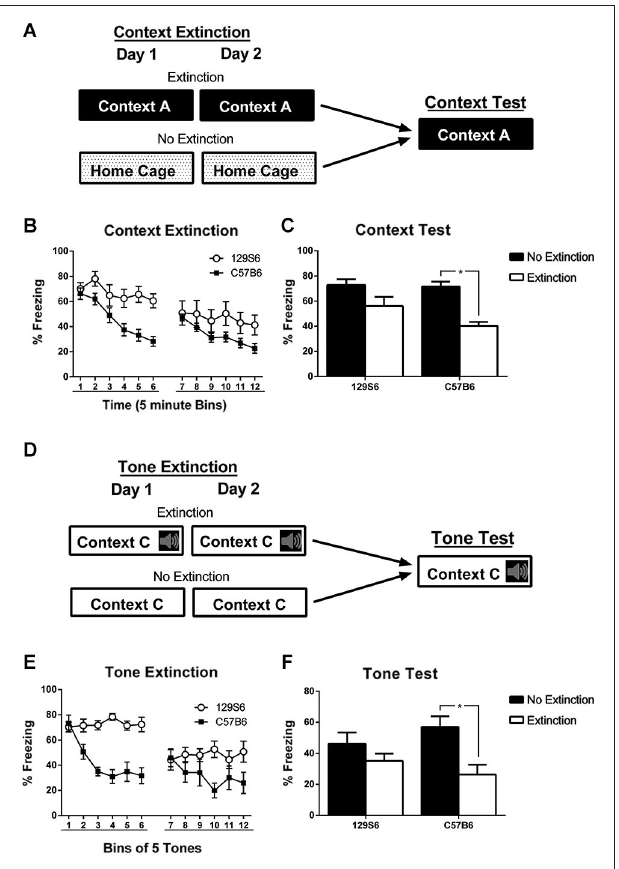
FIGURE 2 | Inbred mouse strain 129S6 shows deficits in context and tone extinction . (A) Schematic representation of context extinction. Mice were trained to a context or tone using 3 tone-shock or unsignaled footshock presentations per day for 3 days. Subsequently, mice were split into extinction and no extinction groups. Mice that were trained to a context were extinguished to the training context using 60 min of context exposure split across 2 days. Mice that were trained to fear a tone were extinguished with 60 tone-alone presentations split across 2 days. Extinction data is binned in groups of 5 min or 5 tones with bins 1–6 representing day 1 of extinction and bins 7–12 representing day 2. Twenty four hours later all mice (both the extinction and no extinction groups) were exposed to the training context or the training tone in a novel context. (B) During context extinction, 129S6 showed high levels of freezing within extinction days 1 and 2 compared to C57B6 mice. (C) During testing, C57B6 mice in the extinction group ( n = 16) showed significantly less freezing than the no extinction controls ( n = 8), while 129S6 mice exhibited similar levels of freezing across both groups ( n = 13 and 7 for the extinction and no extinction groups, respectively). (D) Schematic representation of tone extinction. (E,F) Similar results were observed when C57B6 mice ( n = 7 and n = 8; extinction and no extinction groups, respectively) and 129S6 mice ( n = 8 and n = 9; extinction and no extinction groups, respectively) were extinguished and tested with a tone. Data are represented as mean ± SEM. * p <